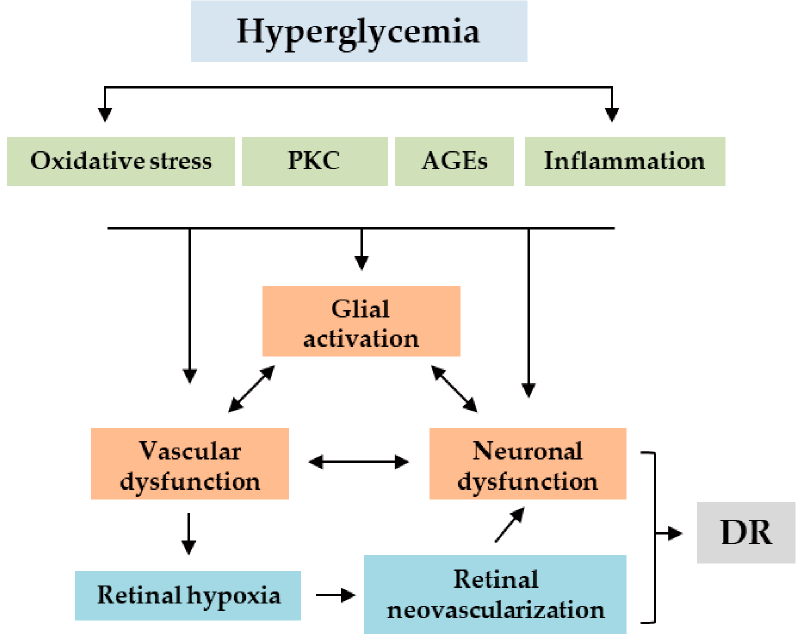
Figure 1. Schematic presentation of pathogenic mechanisms of diabetic retinopathy (DR). Hyperglycemia-induced metabolic stresses, such as mitochondrial oxidative stress, activation of protein kinase C (PKC) pathway, accumulation of advanced glycation end products (AGEs) and inflammation, induce impairment of crosstalk between neurons, glia and vasculatures through glial activation, vascular dysfunction and neuronal dysfunction. Retinal hypoxia induced by vascular dysfunction causes retinal neovascularization which worsens neuronal dysfunction in the retina, finally leading to DR. Double-headed arrows, interlinking process of events; single-headed arrows, one-way direction process of an event to the other event.